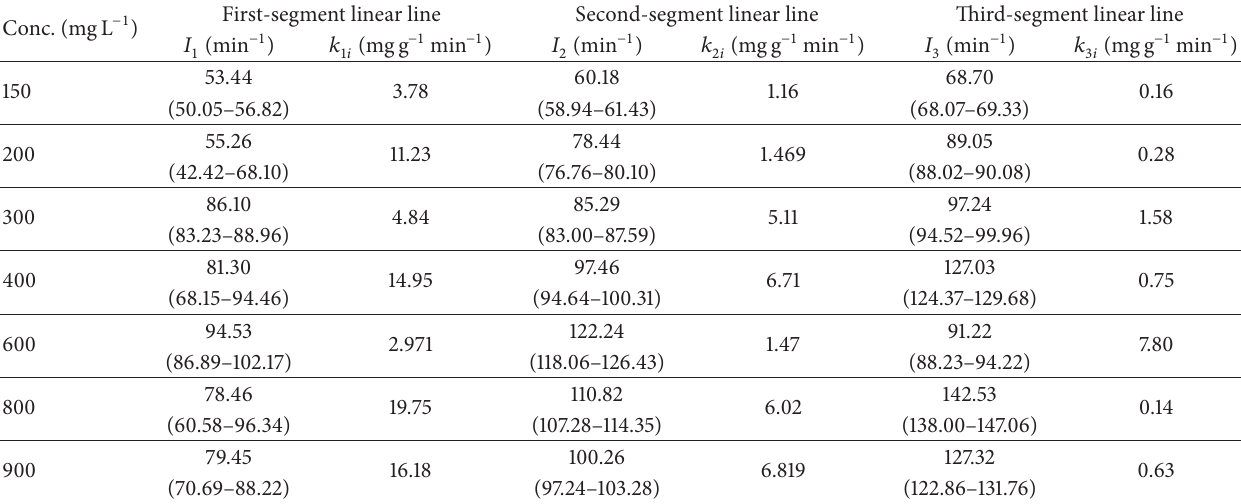
Table 5: Results of piecewise linear regression for the three linear segments in the Webber plots for different initial concentration. The values in parentheses are 95% confidence